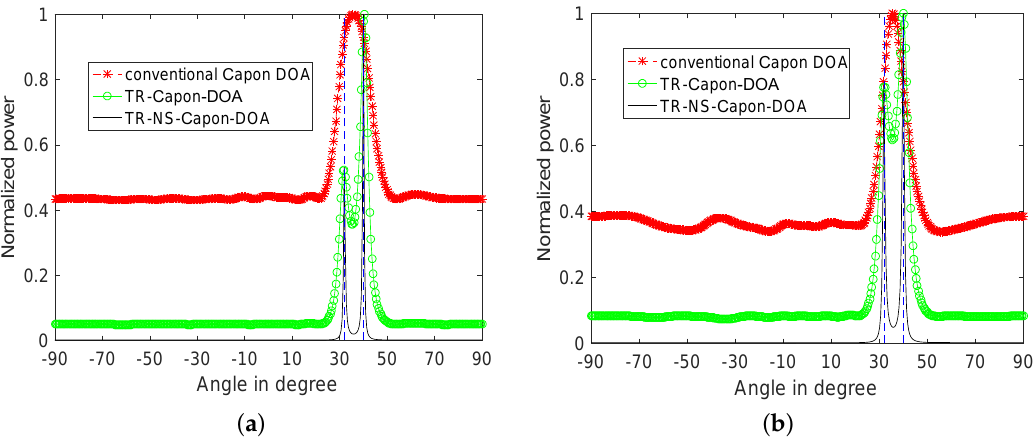
Figure 8. 2-path normalized power spectra versus angles using conventional Capon DOA, TR-Capon-DOA and TR-NS-Capon-DOA algorithms under the condition of SNR = − 15 dB and ULA, ( a ) LFM ( b )